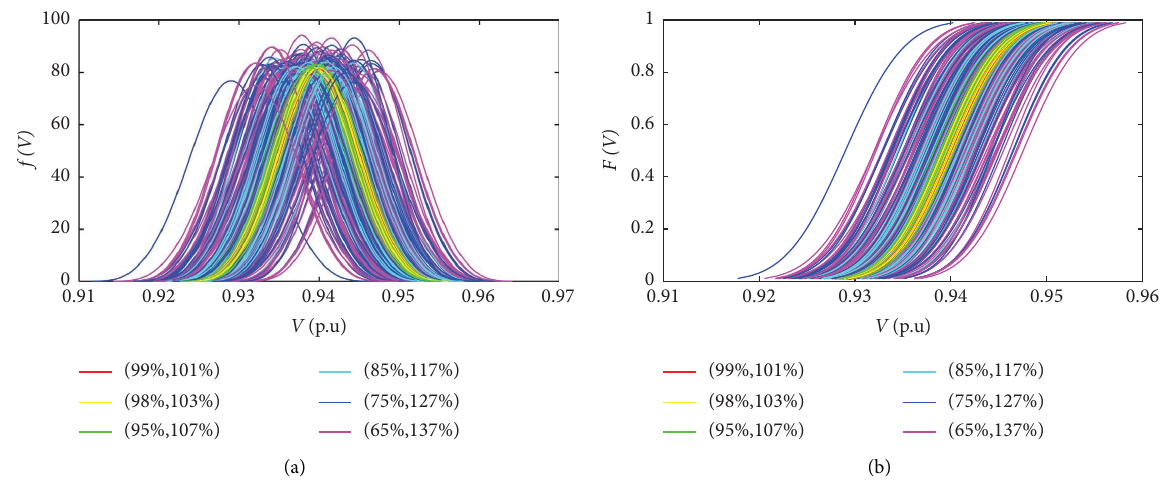
Figure 7: Te PDF and CDF images of V